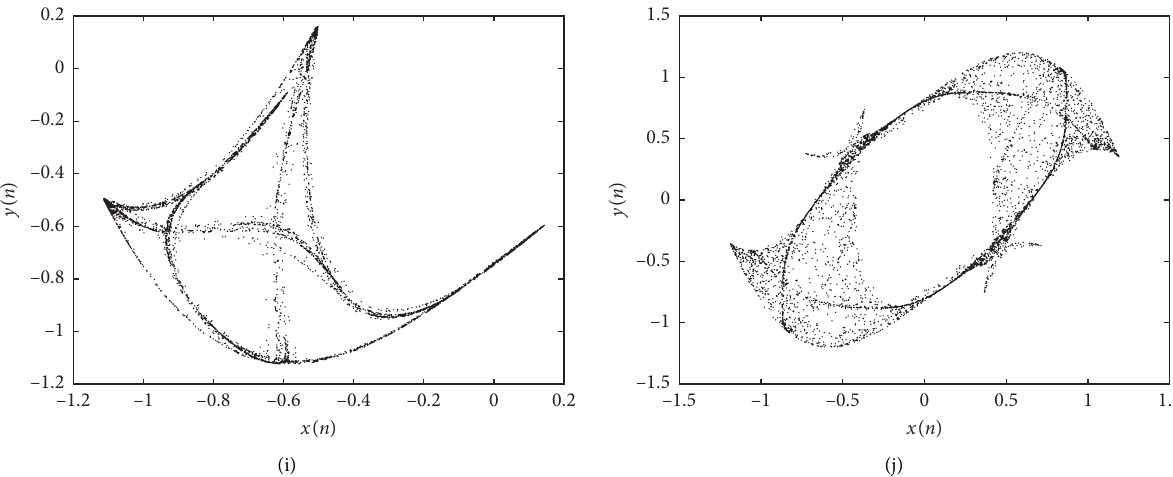
: (a) b � 1, (b) the discrete time evolution of the state variable x ( n ) 01